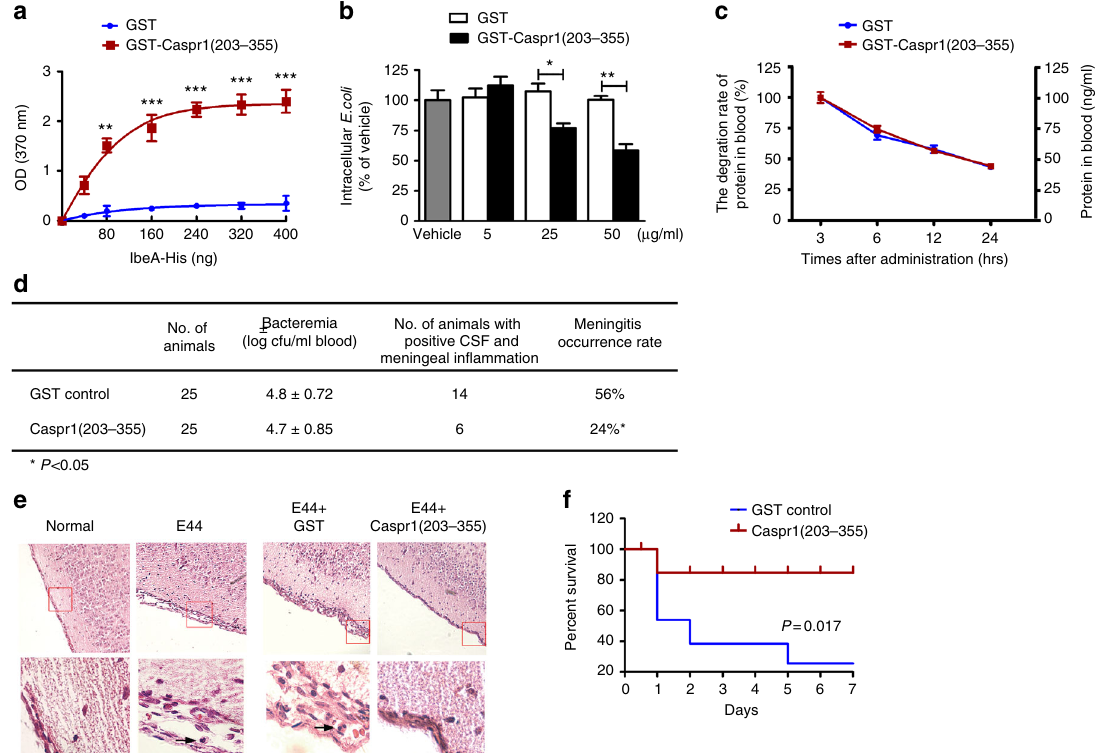
Fig. 5 Caspr1(203 – 355) peptides attenuates bacterial penetration through the BBB leading to reduced E. coli meningitis in neonatal rats. a Recombinant His-tagged IbeA proteins were added to the plate coated with GST-tagged Caspr1(203 – 355) protein, with GST coated plate as control. The binding was assessed by in vitro binding assay by measuring the absorbance at 370 nm. Values are mean ± SD from three independent experiments. ** P < 0.01; *** P < 0.001, one-way ANOVA. b E. coli were pre-incubated with indicated concentrations of Caspr1(203 – 355) recombinant protein for 30 min and then bacterial invasion assays were performed. Values are mean ± SD from fi ve independent experiments. * P < 0.05, ** P < 0.01, one-way ANOVA. c Half-life of Caspr1(203 – 355) recombinant protein in rat blood (30 μ g/rat). Values are mean ± SD from three independent experiments. d , e The neonatal rats were subcutaneously inoculated with 1 × 10 5 CFUs of E44 pre-treated with GST-Caspr1(203 – 355) peptide (30 μ g/rat), with GST protein as control. After 18 h, d the blood samples were collected for bacteremia measurement. The CSF were collected and cultured for bacteria. e The brains were harvested and sectioned for HE staining, and the representative images were provided. The bottom panels are a higher magni fi cation of the boxed regions in the top panels. Arrows indicate neutrophils. Scale, 100 μ m. The rate of meningitis occurrence was calculated by dividing the number of rats with both positive CSF and meningeal in fl ammation by the total number of rats. * P < 0.05, Chi-square test. f Neonatal rats were subcutaneously injected with 4 × 10 2 CFUs of E44 strain together with GST-Caspr1(203 – 355) peptide (30 μ g/rat), with GST protein as control. The daily mortality was recorded and survival curves were plotted. n = 14 (each group). P < 0.05, Log-rank (Mantel – Cox)